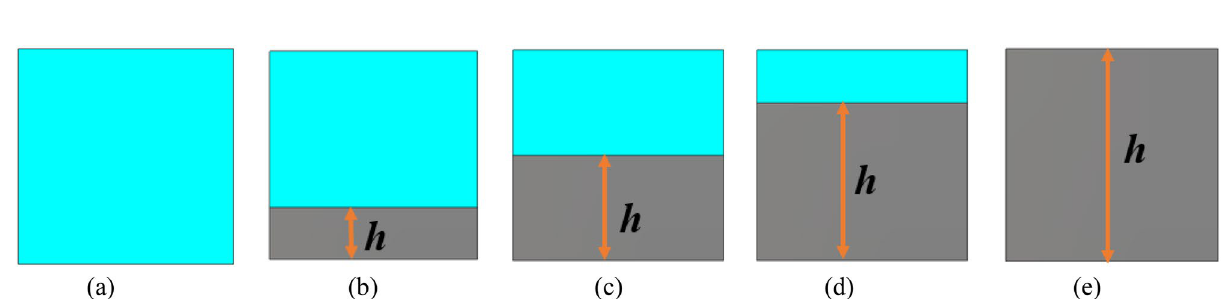
Figure 14. MTM unit cell with several copper back: ( a ) no copper back ( h = 0 mm), ( b ) copper height, h = 2 mm, ( c ) h = 4 mm, ( d ) h = 6 mm ( e ) Full copper back ( h = 8